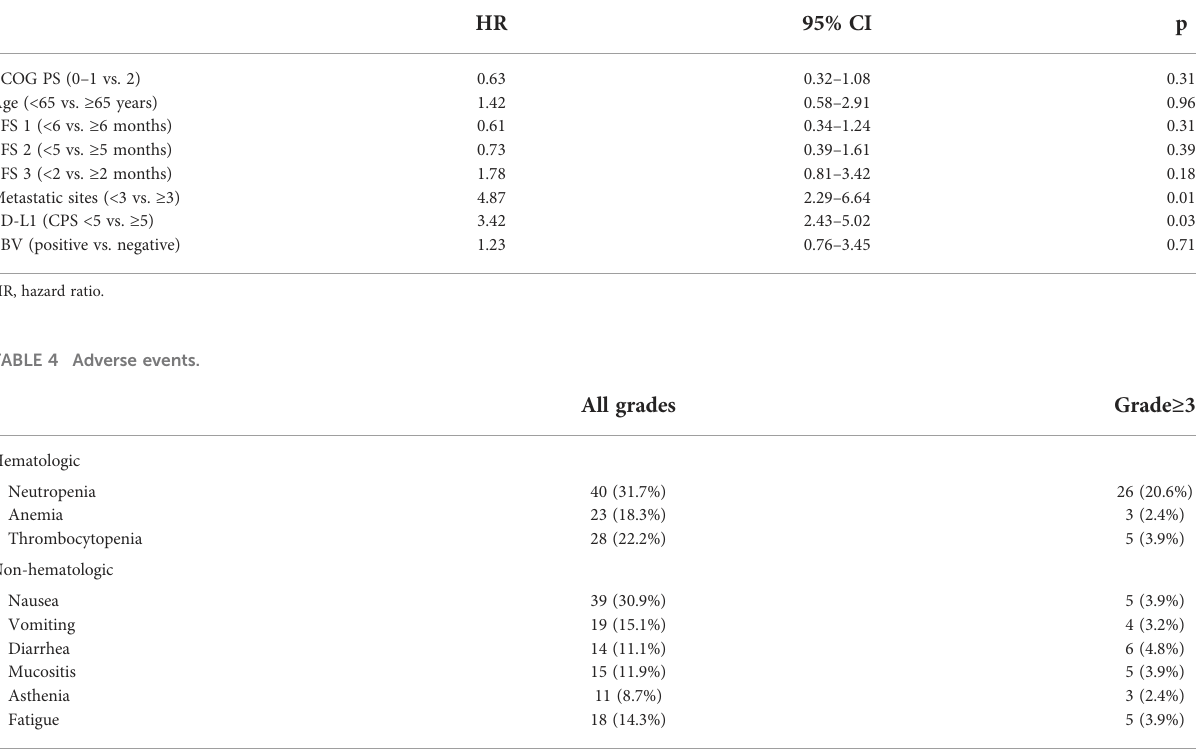
TABLE 3 Multivariate analysis for OS.